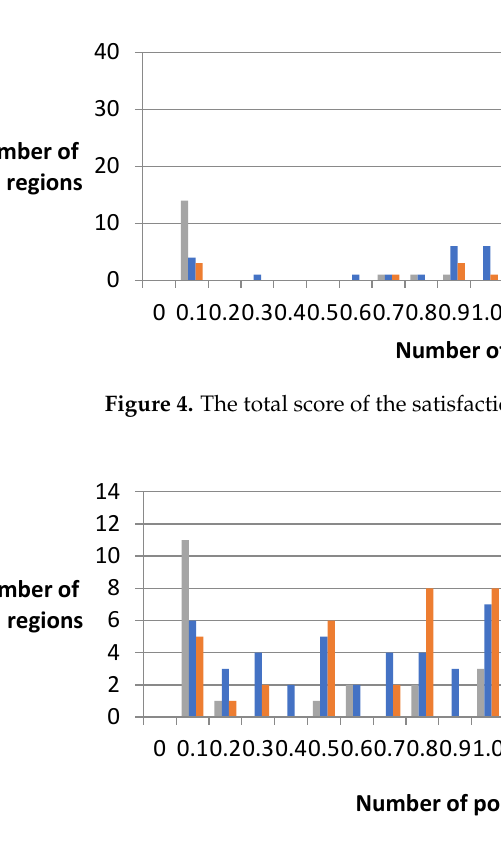
Figure 5. The total score of the staffing of organisations providing rehabilitation and/or habilitation services with specialists of the appropriate profile based on the needs of PwD in rehabilitation and/or habilitation services.